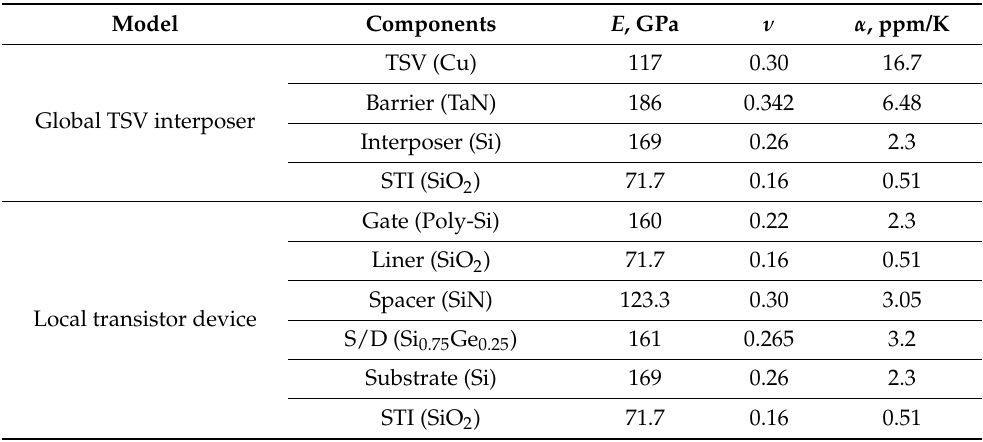
Table 1. Material characteristics utilized in this study for analytical stress calculation and FEA stress simulation .